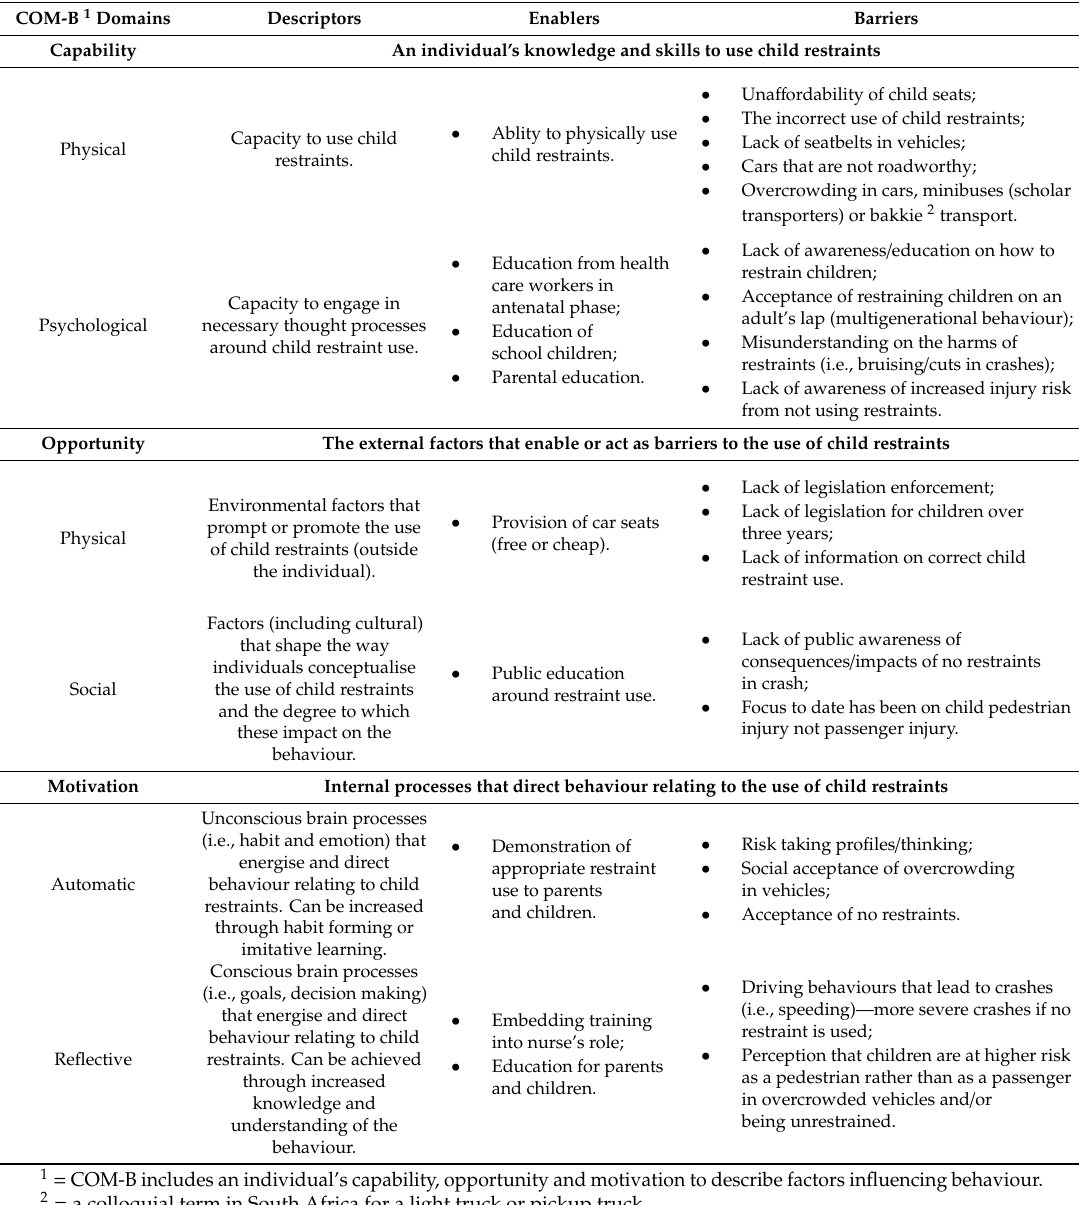
Table 1. Descriptors of child restraint use in the COM-B domains and themes developed (enablers and barriers) from participant interviews in Cape